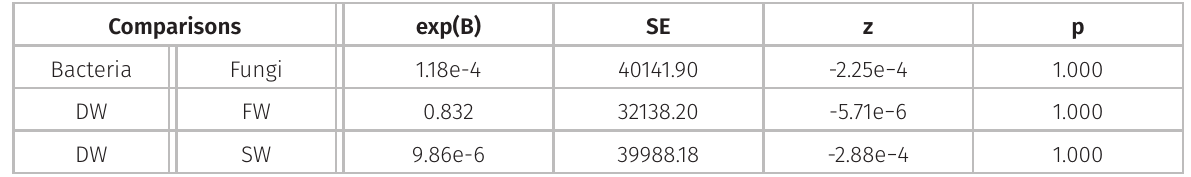
Table I. Negative binomial regression analysis of microorganism counts from water collections.